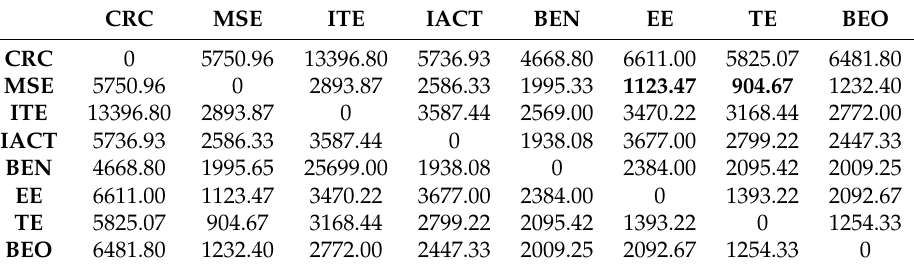
Table 5. The distance between fingerprint databases of all buildings.